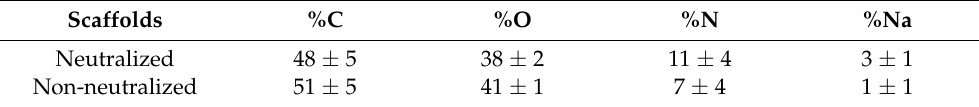
Table 1. EDX elemental composition of neutralized and non-neutralized chitosan/AH.